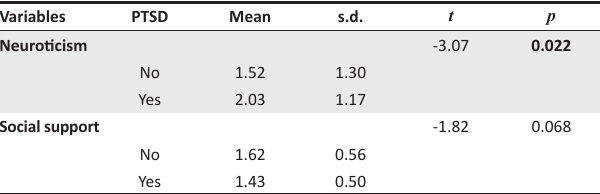
TABLE 3: Neuroticism and social support comparison between post-traumatic stress disorder caseness and non-caseness. Variables